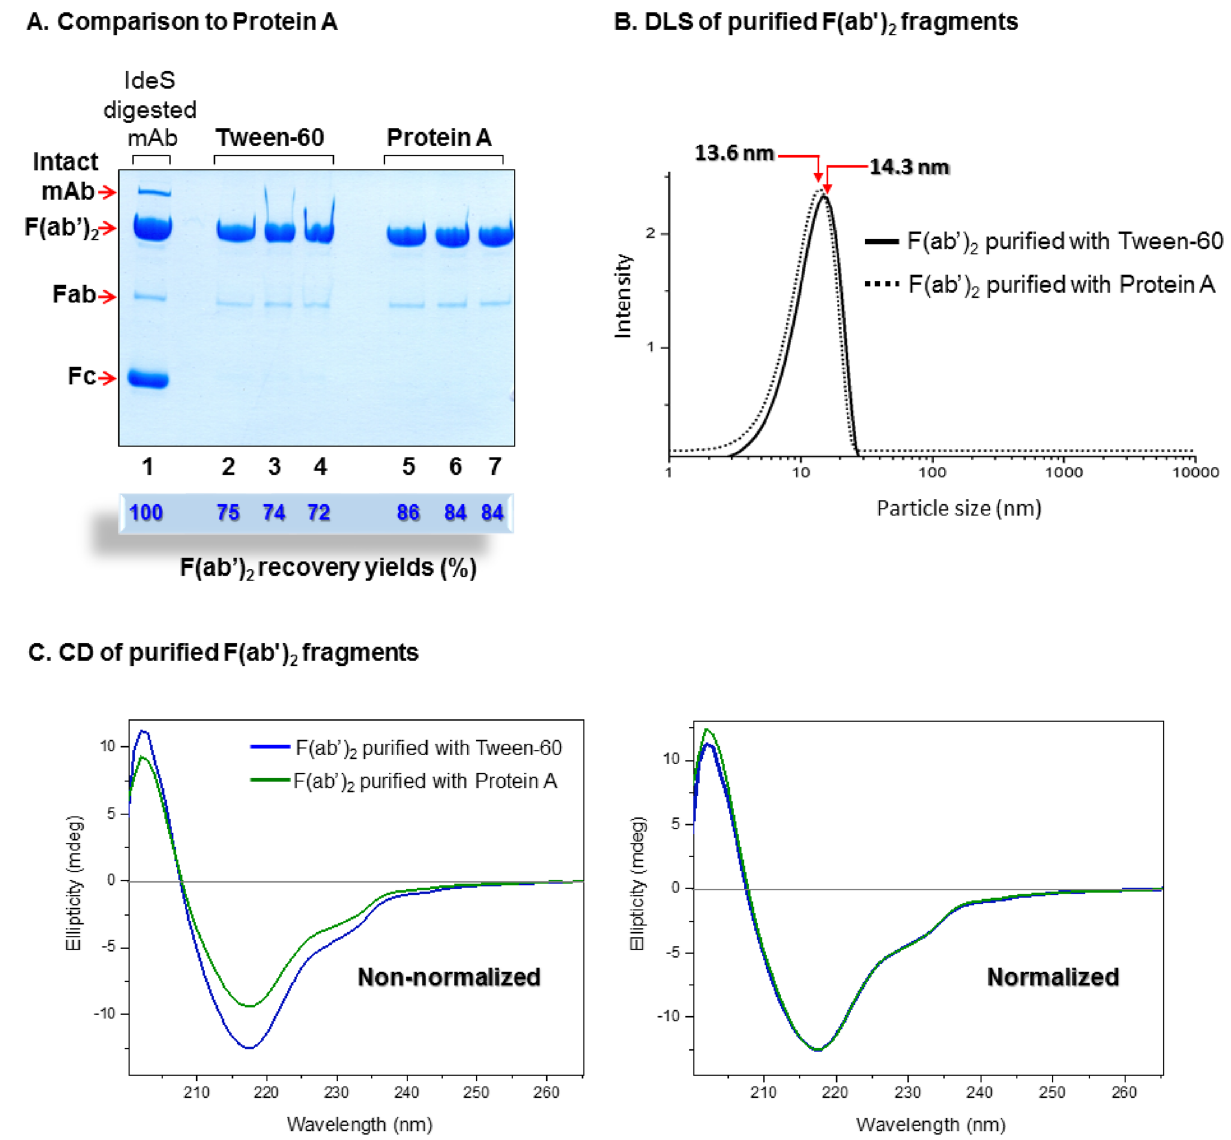
Figure 6. Comparison of detergent aggregate purification and Protein A purification of fragments from IdeS digested mAb. ( A ) Lane 1: IdeS digested mAb; lanes 2–4: F(ab ′ ) 2 recovered after incubation of IdeS digested mAb with Tween-60 aggregates and following extraction as described in the Experimental section; lanes 5–7: flow-through composition after IdeS digestion (as shown in lane 1) and followed by removal of the F c domain on a Protein A column. Overall F(ab ′ ) 2 recovery yields are indicated below each lane. The gel is Coomassie stained. E. Coli lysate was not added. ( B ) Dynamic light scattering (DLS) of F(ab ′ ) 2 fragments purified with either Tween-60 aggregates or a Protein A spin column. ( C ) Circular dichroism (CD) spectra of F(ab ′ ) 2 fragments purified with either Tween-60 aggregates or a Protein A spin column (Both the non-normalized and normalized spectra are presented. Normalization of the spectra is performed at 218